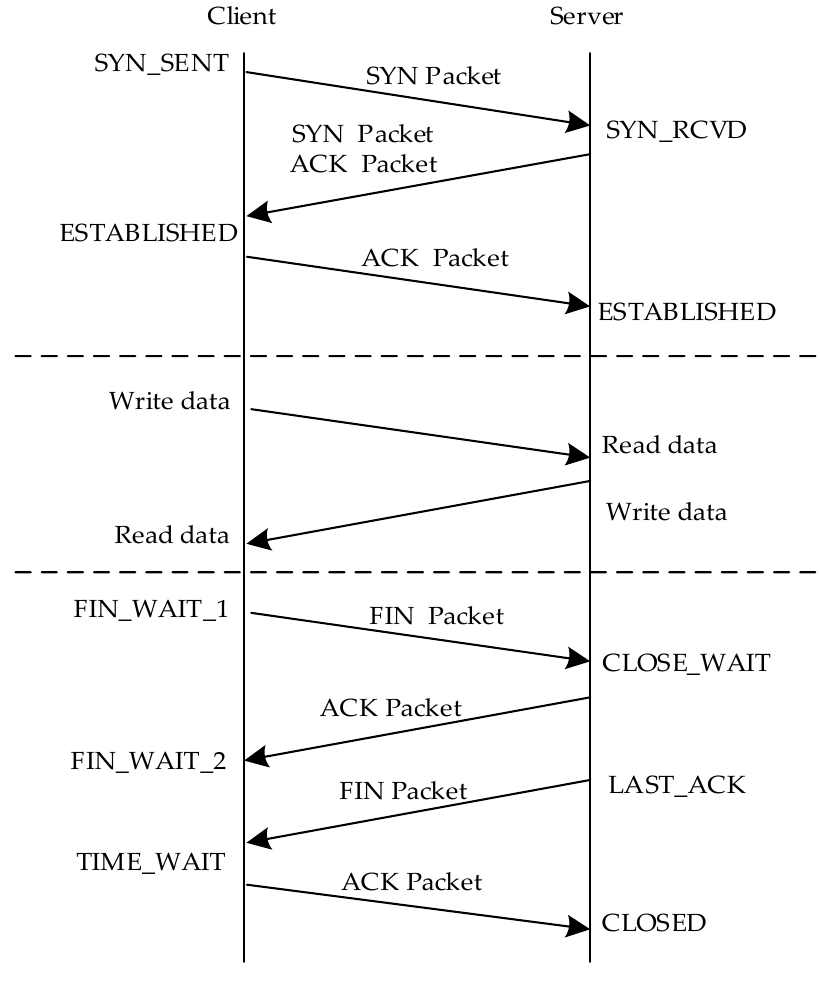
Figure 15. The data transmission time